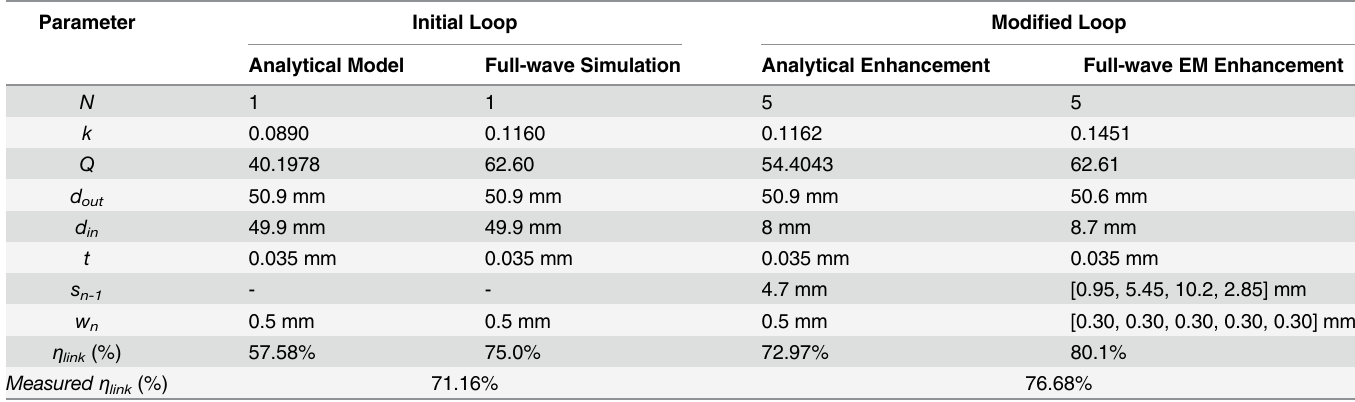
Table 1. Loop Geometric and Performance